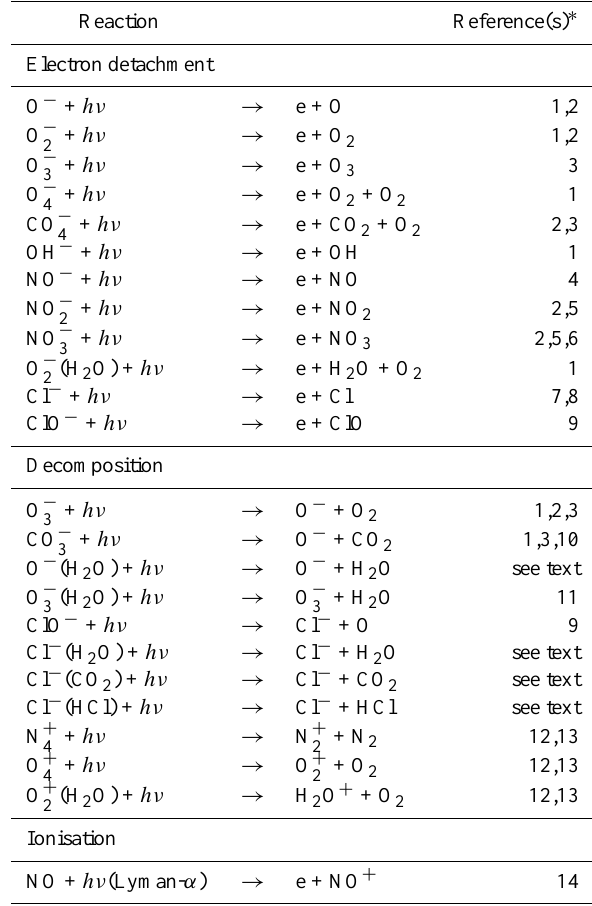
Table 3. Photoelectron detachment, photo-dissociation of ions, and photo-ionisation in the model. The rate coefficients are calculated using cross-section data from the